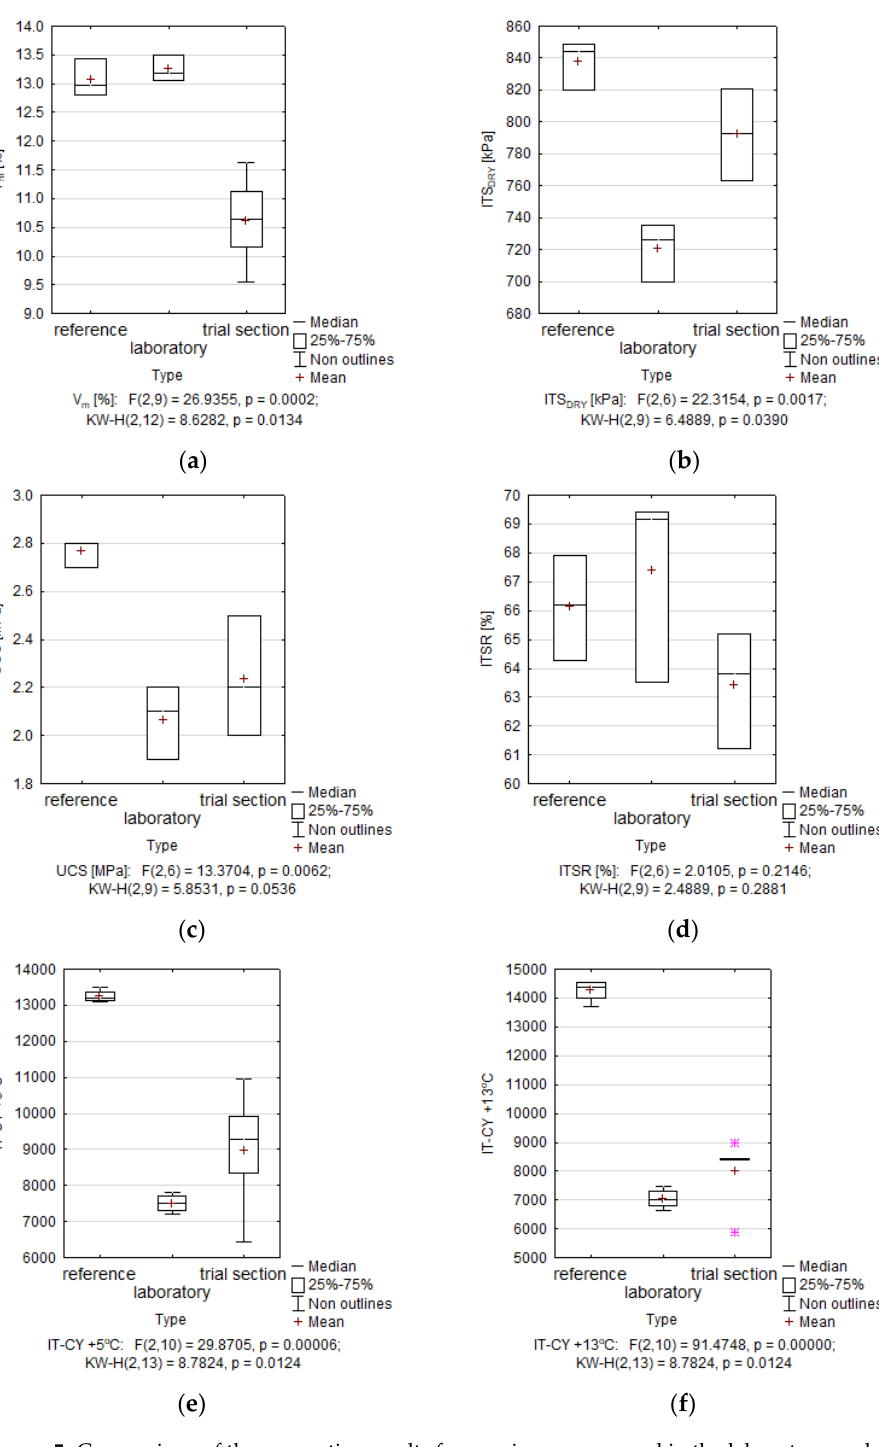
Figure 5. Comparison of the properties results for specimens prepared in the laboratory and col- lected from the trial section with the results for specimens prepared using solely with the reference cement binder: ( a ) Void content V m ; ( b ) Indirect tensile strength ITSdry; ( c ) uniaxial compression strength UCS; ( d ) indirect tensile strength ratio ITSR; ( e ) indirect strength stiffness modulus at 5 °C deg. IT-CY, ( f ) indirect strength stiffness modulus at +13 °C deg. IT-CY.